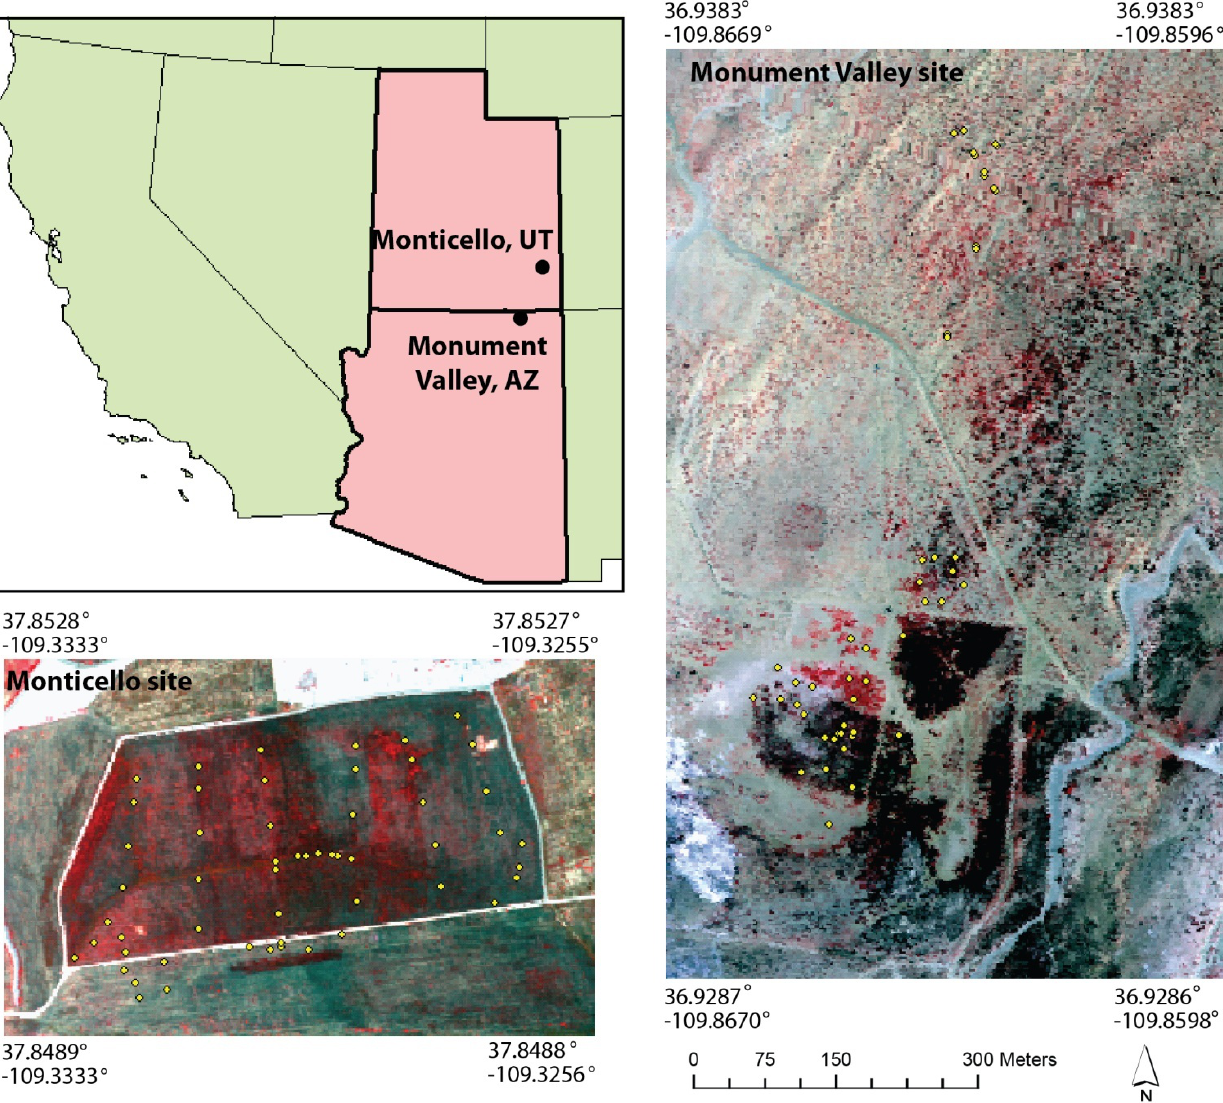
Figure 1. The HyMap imagery of two study sites (RGB = Hyperspectral bands 24, 17, 11). The yellow symbols are in situ sampling